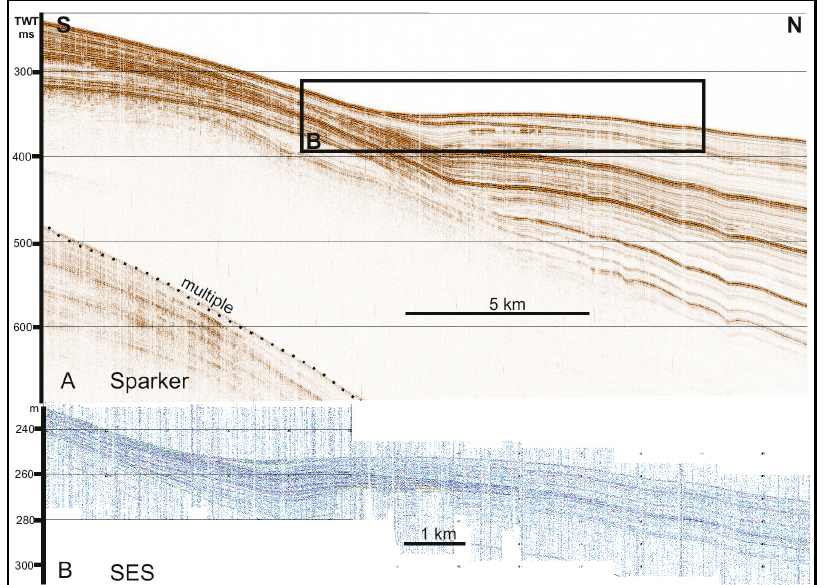
Figure 12. Contourite plastered drift on the southern slope of the Derbent Basin near the Apsheron Sill. Fragment of the profile (sparker) roughly S-N across the slope. ( A ) Fragment of the profile (sparker). ( B ) Enlarged fragment of ultra-high-resolution seismic reflection profile (SES) showing in detail uppermost sedimentary layer. Location in Figure 2.